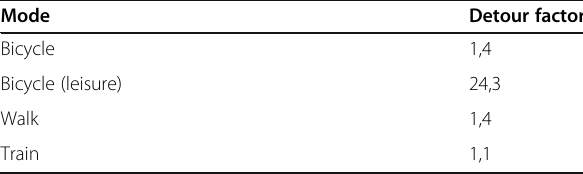
Table 1 Examples of typical detour factors from the data set Mode Detour